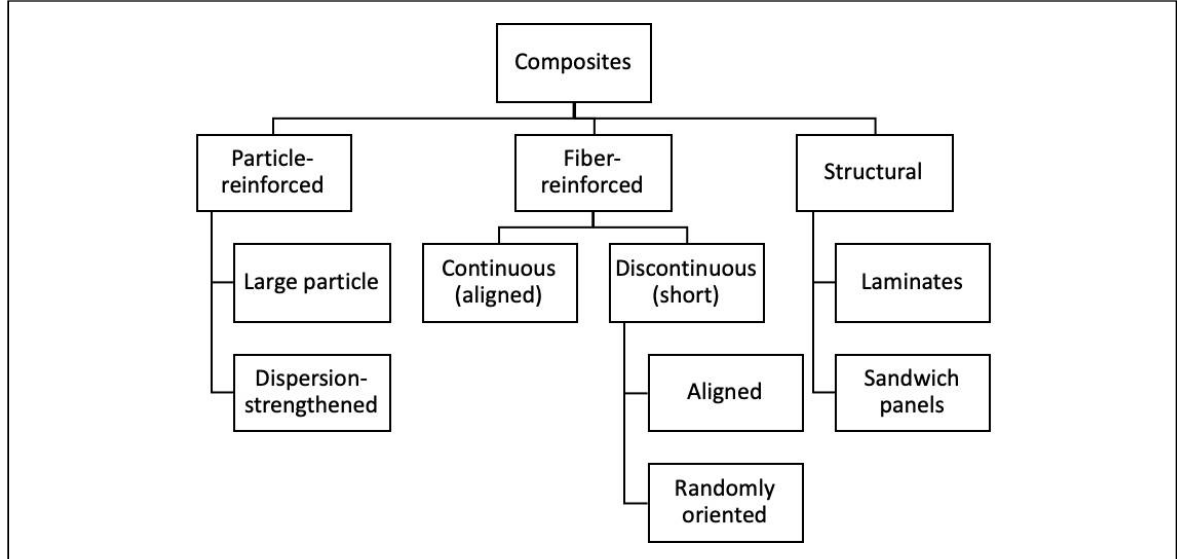
Figure 2: Composites classified by reinforcement, Adapted from Callister and Rethwisch,